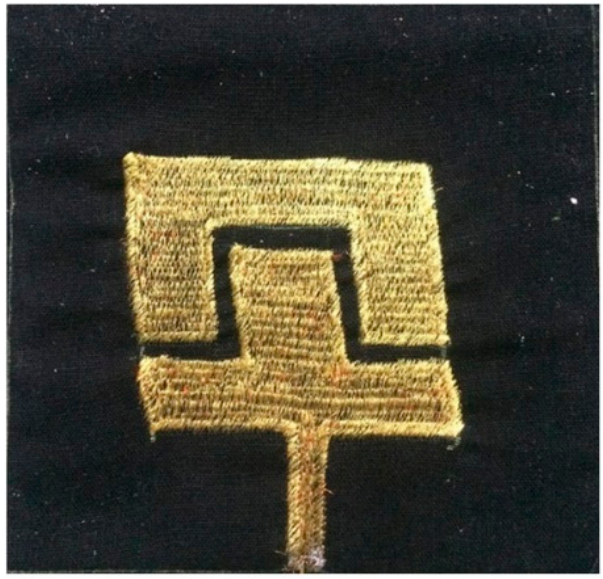
Figure 6. Example of a textile-based implementation of the microstrip patch antenna design using embroidered Zari (silver metallic yarn wrapped on a silk core) as radiating patch. Reprinted with permission from [74]. Copyright 2019, Wiley Periodicals, Inc.